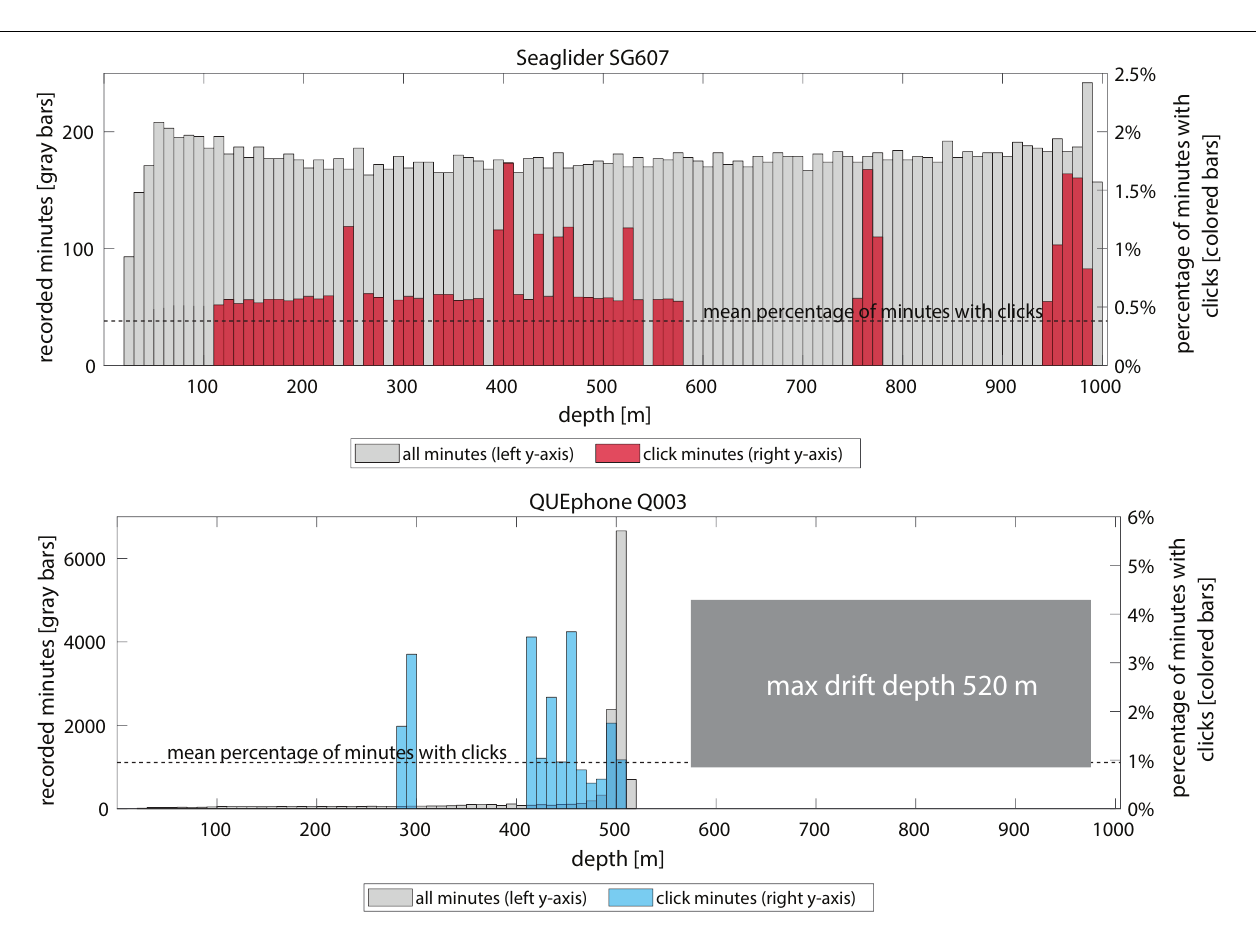
Frontiers in Marine Science |